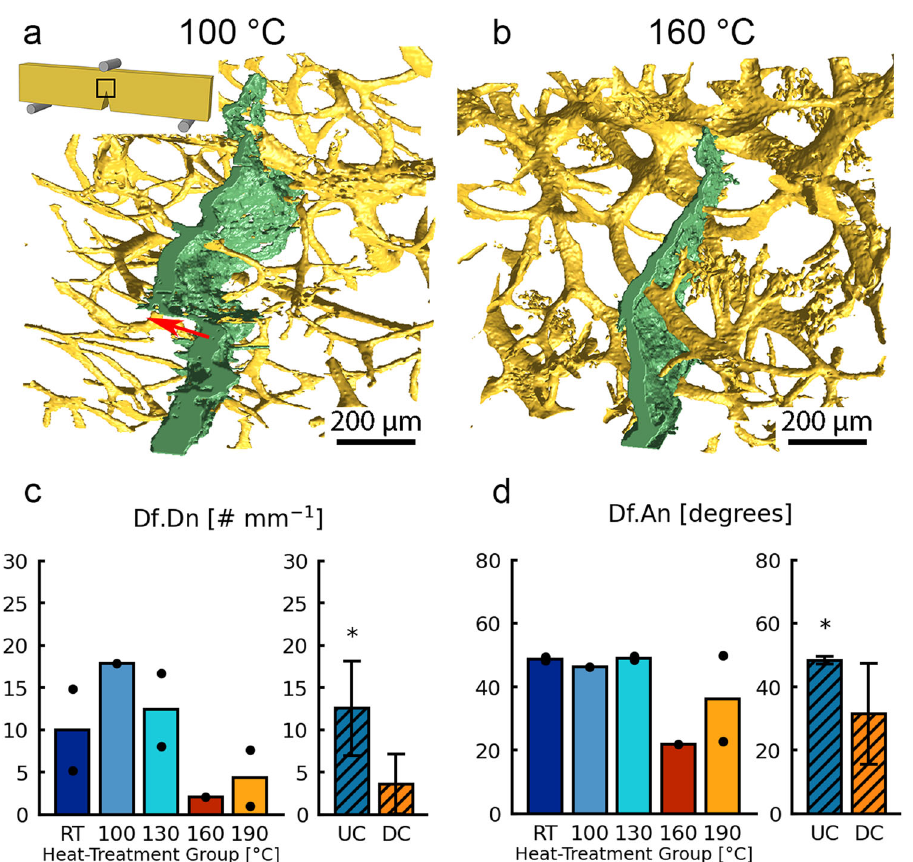
Fig. 4 The amount of crack de fl ection was reduced due to damaged collagen. a , b Segmentation of bone samples after toughness testing, with canals colored in yellow and the crack path colored in green for both 100 °C and 160 °C samples. The red arrow indicates a large crack de fl ection in a 100 °C sample. c Crack de fl ection density, number of crack de fl ections per length of crack extension (Df.Dn), was reduced in the DC groups compared to the UC groups. d The average angle of crack de fl ection (Df.An) shows that UC groups exhibit more salient crack de fl ection than DC groups. In graphs, c , d the bars for each temperature represent the mean and each data point is shown as a black dot ( N = 1 – 2/group). The bars for the UC and DC groups show the mean and standard deviation ( N = 3 – (Fig. 2b), reinforcing the importance of crack de fl ection as a salient toughening mechanism in bone.